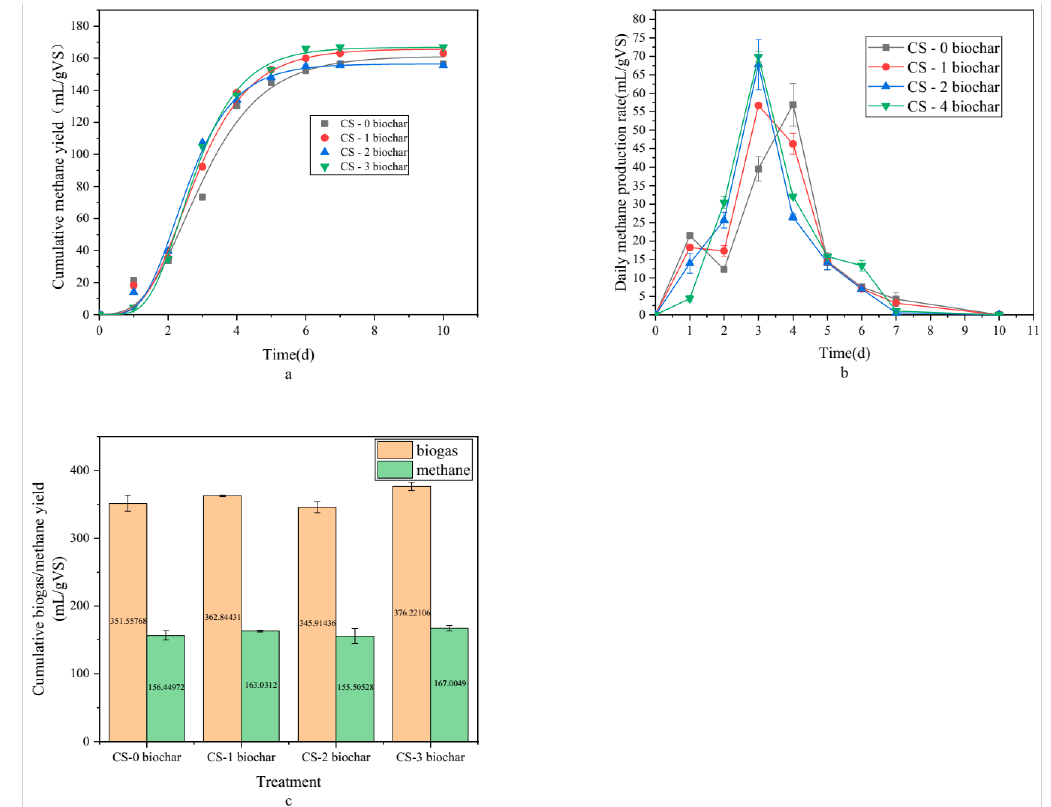
Figure 2. ( a ) Cumulative methane yield and the fitting curve using the modified Gompertz model; ( b ) daily methane production rate; ( c ) ultimate biogas/methane production, during anaerobic digestion. Table 2. Calculated results using the modified Gompertz equation for methanogenesis in different treatments.